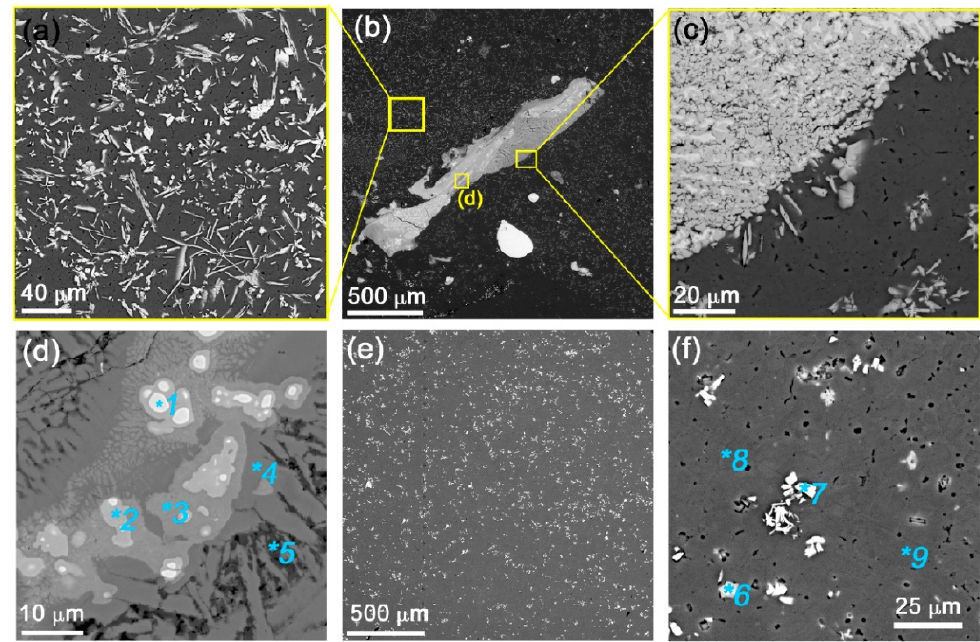
Figure 10. SEM SE ( a , c ) and BSE ( b , d – f ) images of zone 2 AA5154/Mo microstructures obtained with 0.9 g/layer Mo. Numbers 1–9 denote point selected for EDS (Table 5). Table 5. EDS analysis of the AA5154/Mo with 0.9 g/layer was obtained by using SEM (Figure 10d,f). Concentration of Elements, at.% Spectrum